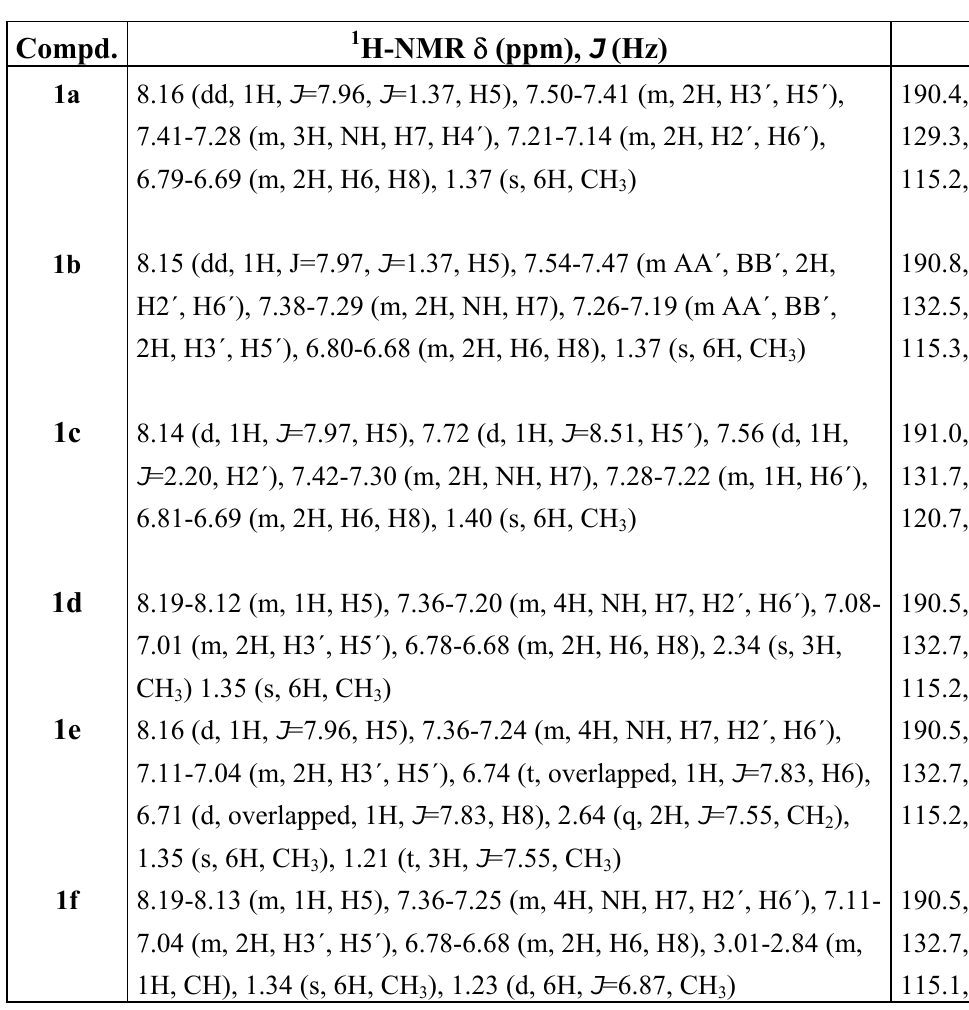
Table 2. 1 H-NMR and 13 C-NMR spectral